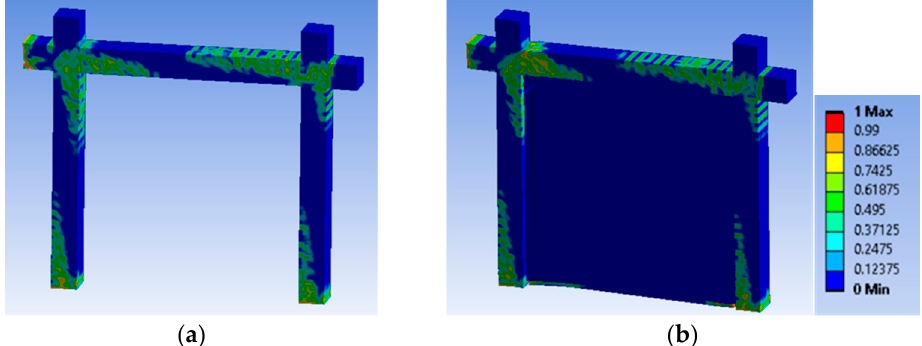
Figure 13. Concrete damage of specimens with 11 d bL lap length of ( a ) A1F; ( b ) B2.